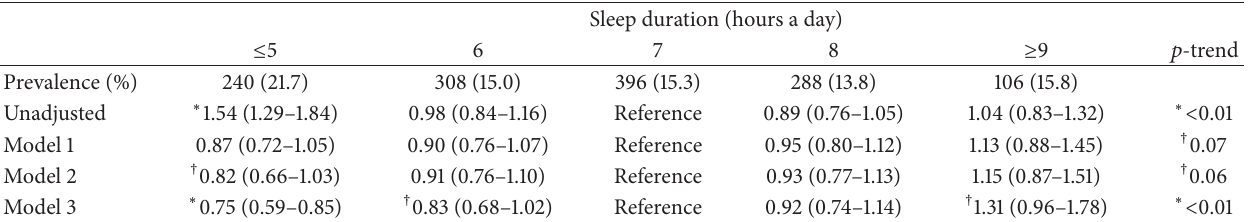
Table 3: Prevalence (%) and odds ratio (95% confidence interval) for the metabolic syndrome meeting ATP III criteria according to sleep